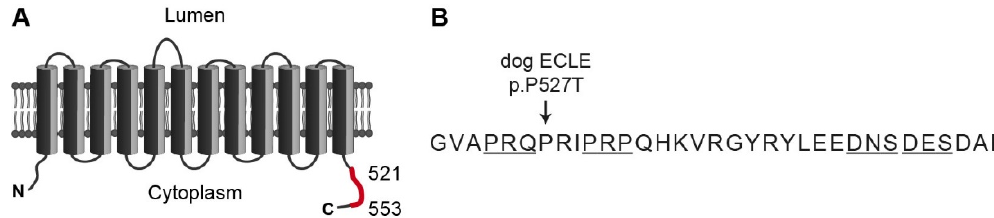
Figure 1. Topology of the human UNC93B1 protein. ( A ) UNC93B1 comprises 597 amino acids and contains 12 transmem- brane domains. A segment of the C-terminal tail indicated in red is required for the interaction with SDCBP and subsequent dampening of TLR7 signaling [18]. ( B ) Amino acid sequence from position 521 to 553. Substitution of a highly conserved proline with threonine causes exfoliative cutaneous lupus erythematosus in dogs [22]. Targeted mutagenesis of the four underlined motifs disrupted SDCBP binding in mouse macrophages [18]. A targeted mouse mutant, Unc93b1 PKP/PKP , in which the residues corresponding to the human positions 530-532 were replaced by alanines, developed systemic in- flammation and autoimmunity [18].